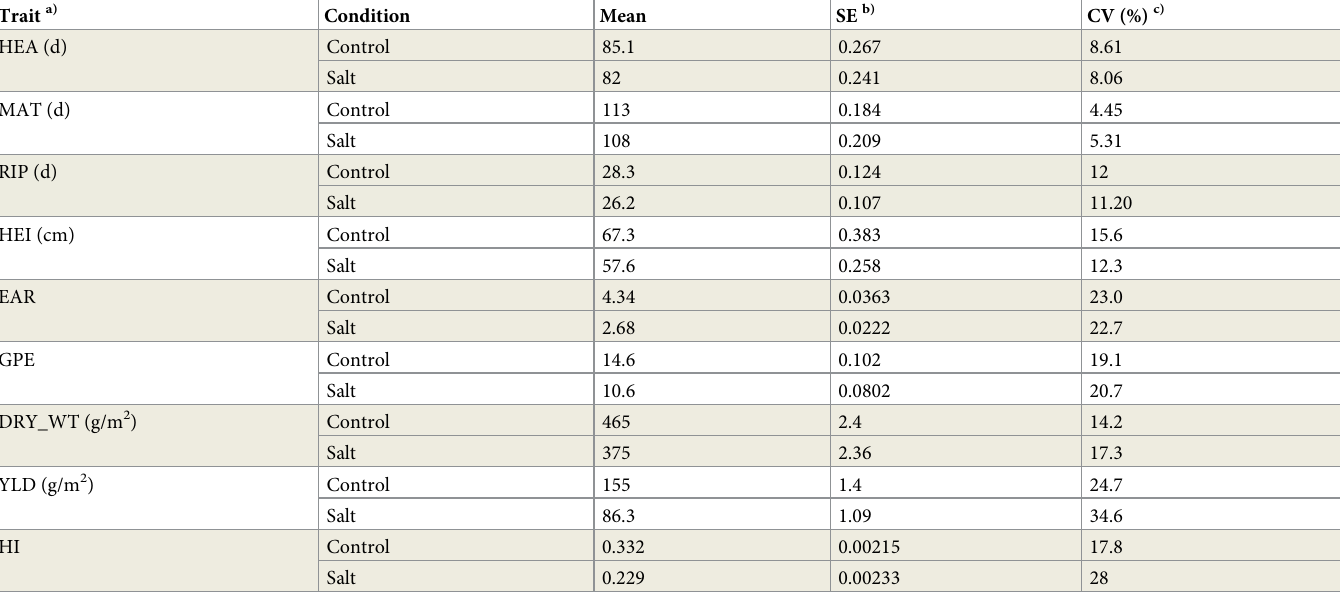
Table 1. Effect of the salt treatment on agronomic traits measured in the field. Trait